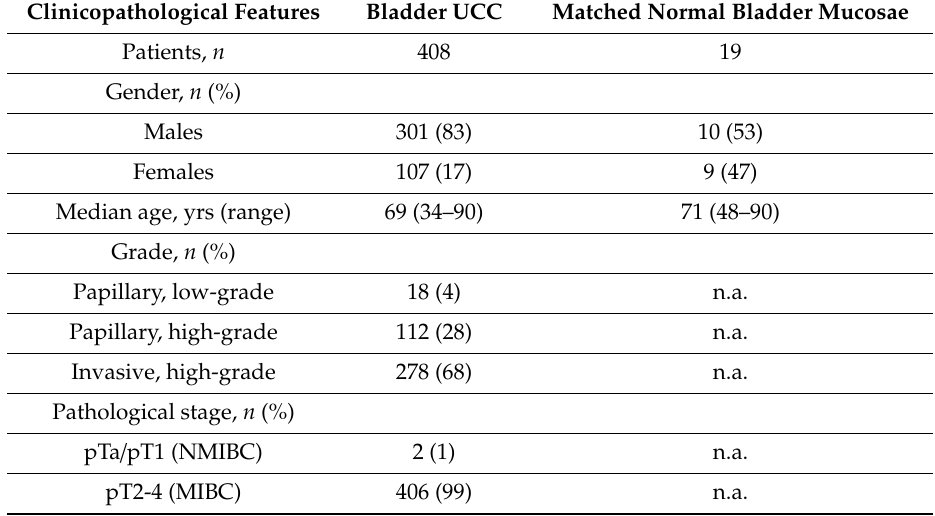
Table 2. Clinical and histopathological parameters of bladder cancer patients, and gender and age distribution of control set individuals from TCGA